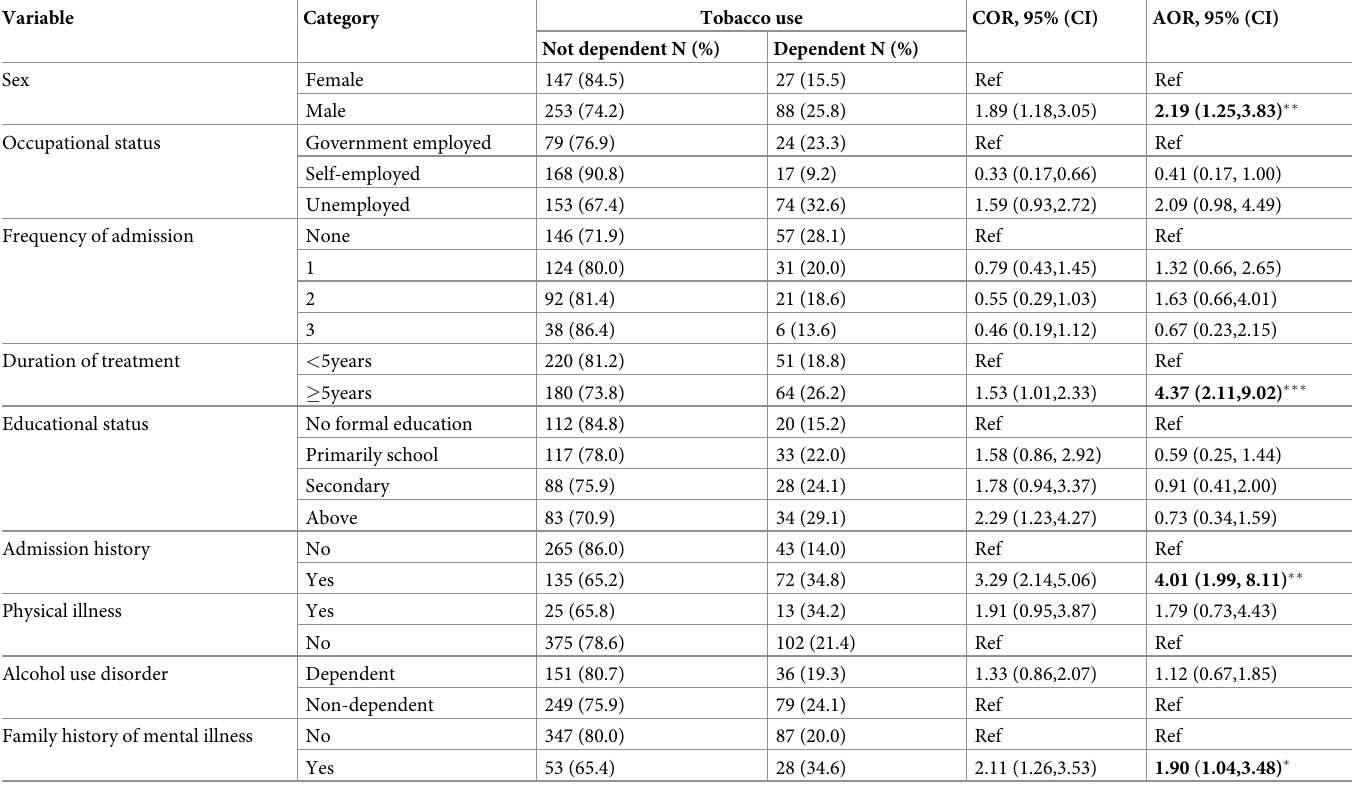
Table 4. Factors associated with tobacco dependence among schizophrenic patients at Mettu Karl referral, Bedelle and Agaro hospitals, southwest Ethiopia, 2020 (N = 515).